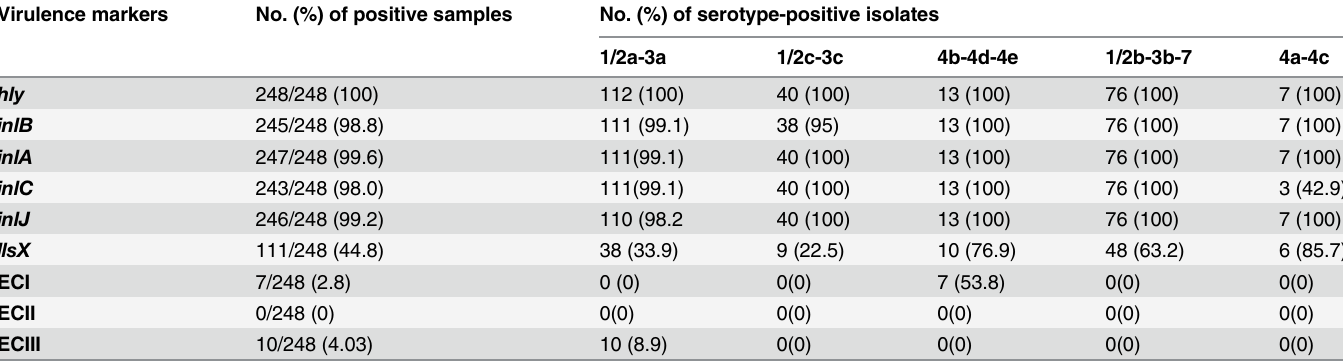
Table 5. Virulence markers of 248 Listeria monocytogenes strains in positive samples. Virulence markers